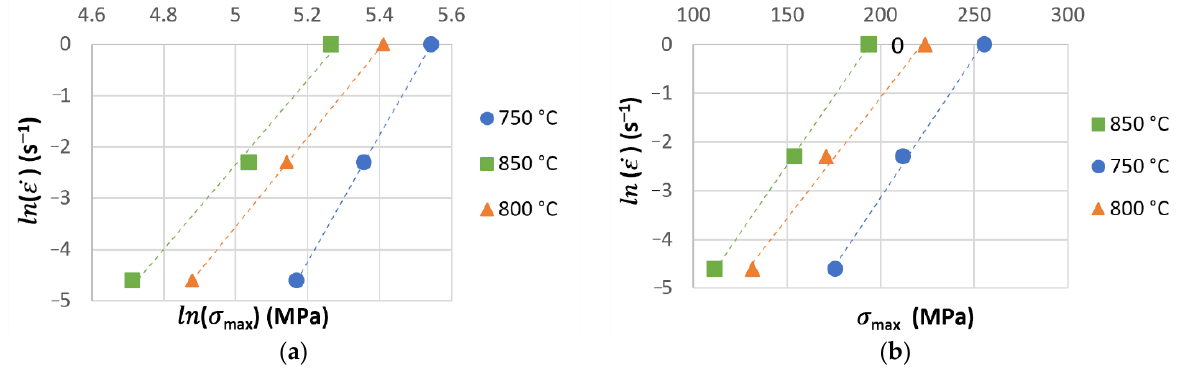
. . ε and ln σ max ( b ) ln ε and σ max .